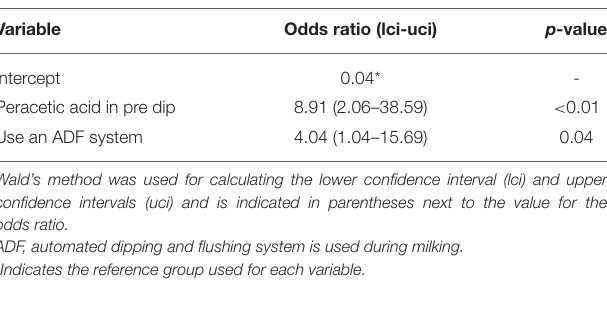
TABLE 6 | The reported associations with chapped teats as the outcome variable ( n = 101